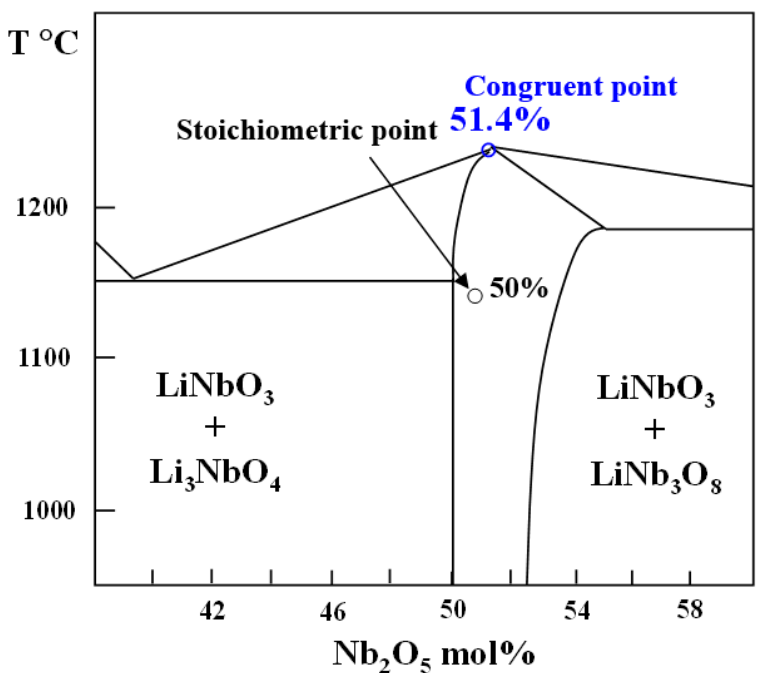
Figure 3. Schematic equilibrium phase diagram of binary system of Li 2 O and Nb 2 O 5 m in the vicinity of LiNbO 3 .